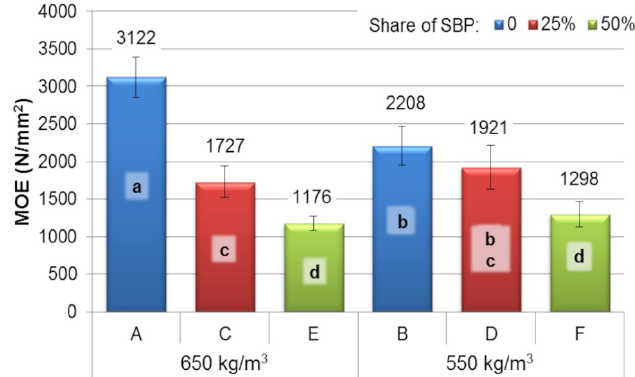
Figure 2. Modulus of elasticity of particleboards. a,b,c,d—homogenous group by Tukey test ( α = 0.05).